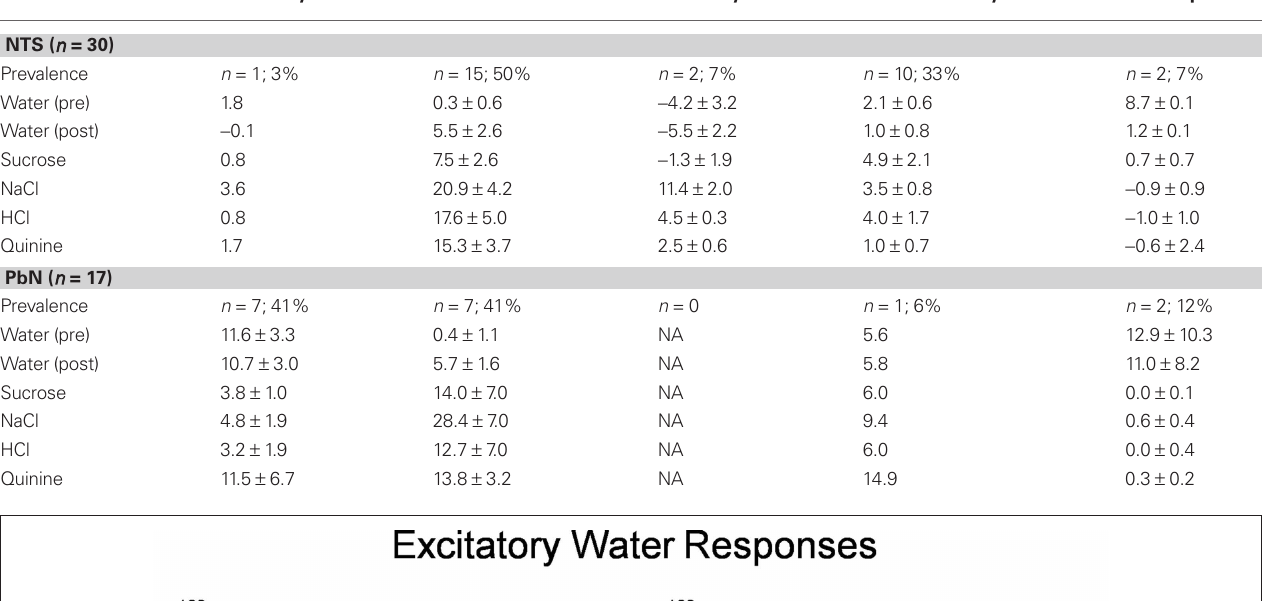
Table 1 | Mean responses ± SeM for water and all taste stimuli in water-response cell types. excitatory Conditional inhibitory Somatosensory Water specialist